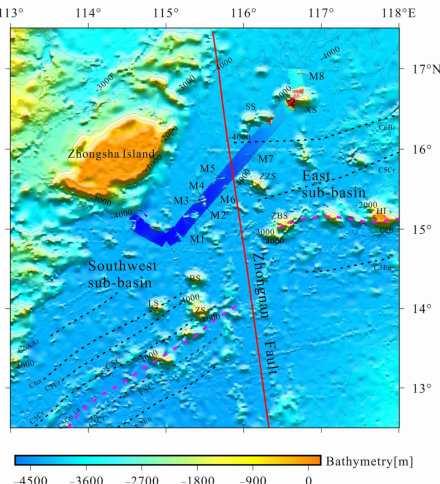
Figure 10. Multi-beam bathymetry map of seamounts in the southwest and east sub-basins. The background bathymetric data is from the General Bathymetric Chart of the Oceans [40]. The central band shows the bathymetry data acquired by the R/V “Dongfanghong 3”. The red dotted line represents the location of the inferred Zhongnan fault [18,87,88]. The purple dotted line represents the spreading center of the southwest and east sub-basins [88]. The magnetic anomaly stripes (labeled C5 and C6) are from deep-tow magnetic surveying [88]. ZS: Zhongnan Seamount; LS: Longbei Seamount; BS: Beiyue Seamount; ZBS: Zhenbei Seamount; HI: Huangyan Island; ZZS: Zhangzhong Seamount; SS: Shixing Seamount; XS: Xianbei Seamount; CSC: Changlong seamount chains; FSC: Feilong seamount